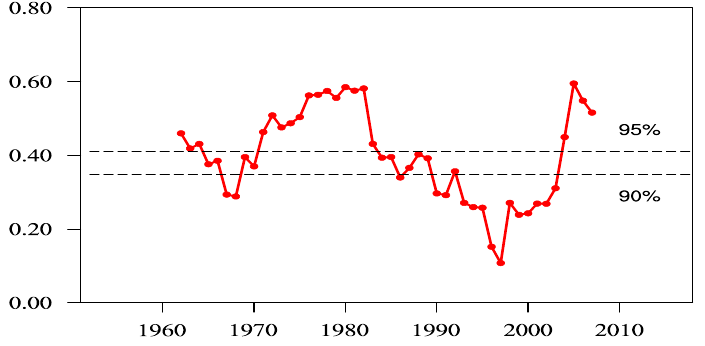
Figure 6. Time series of the running correlation with a 23-year window between the EAP index (multiplied by − 1.0) and the normalized IPWP index during 1951–2018.